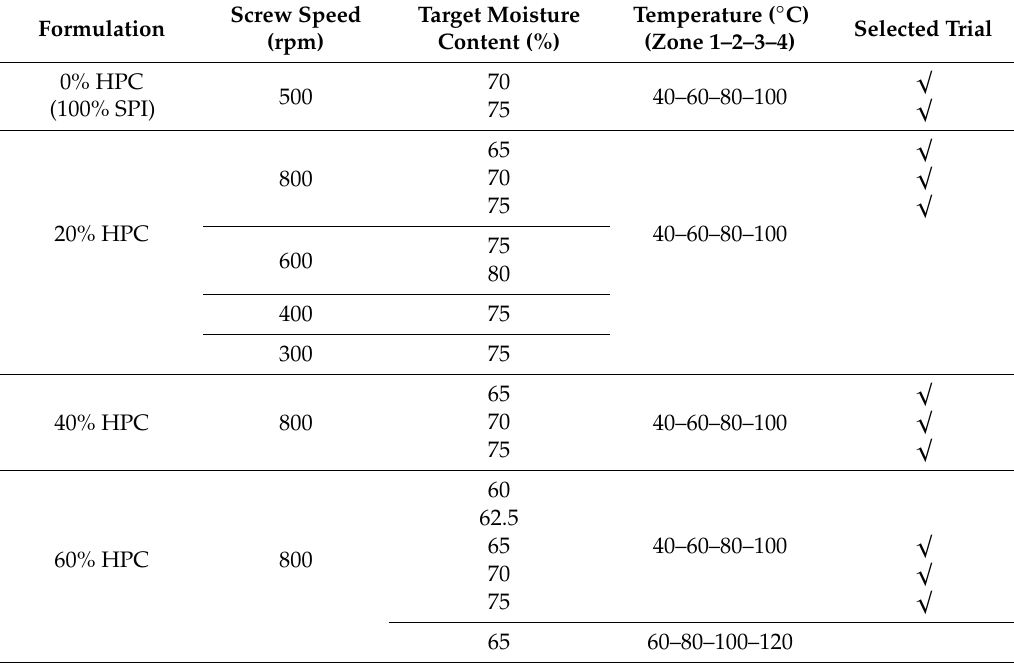
Table 2. Extrusion parameters involved in the screening and selected formulations of